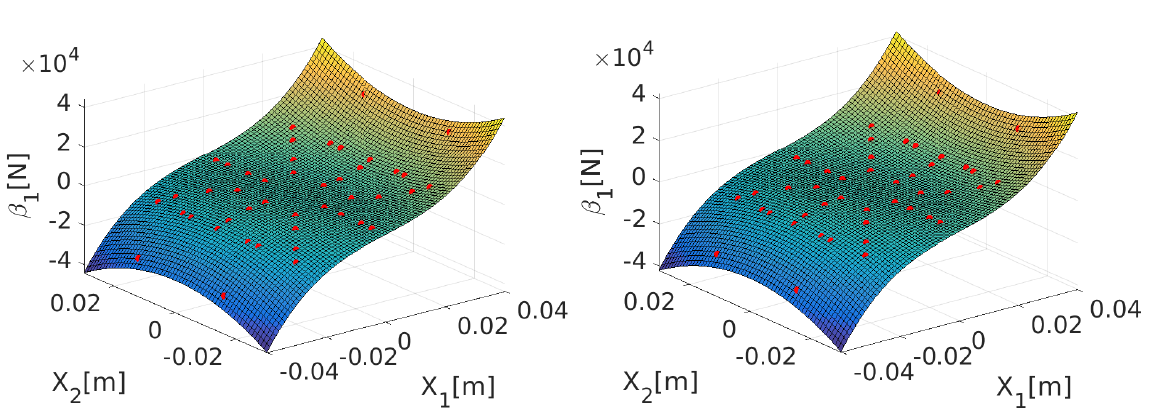
Figure 8. Illustration of the fitting procedure in the ICE method with two master modes for the case of the clamped beam without detuning ε = 0 ( left ) and with detuning ε = 4.92% ( right